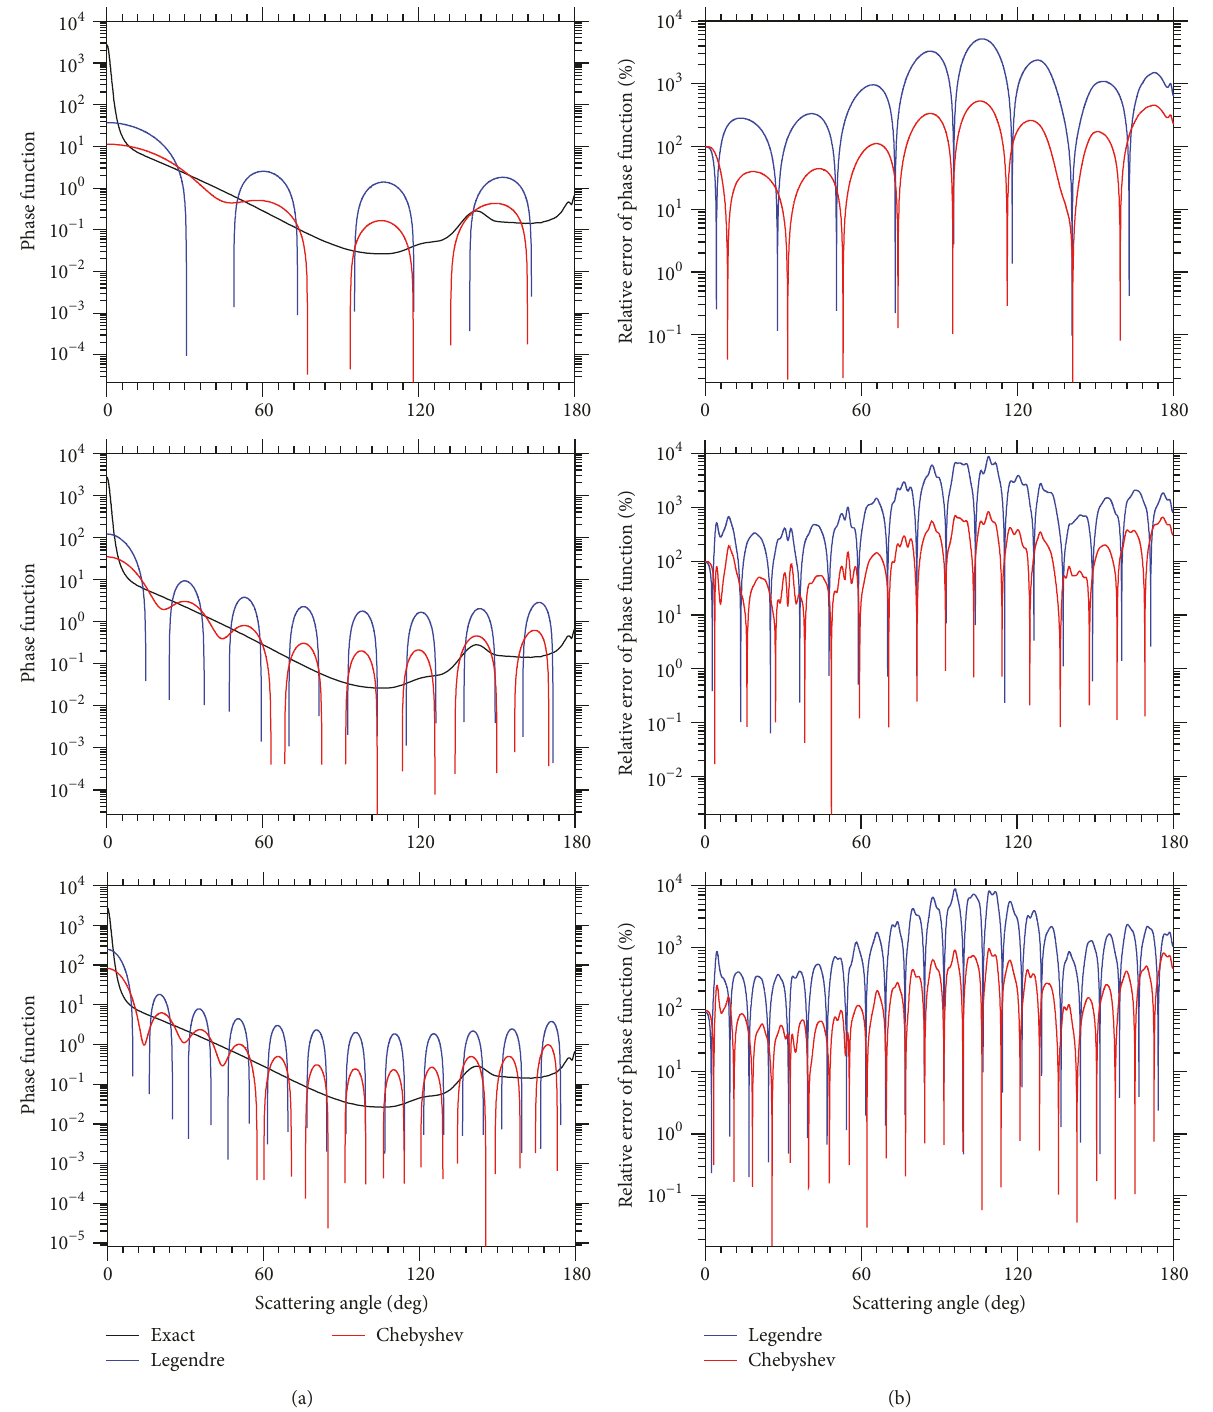
Figure 4: Phase function of black carbon internally mixed with water cloud (a) and relative error of phase function (b) in 8, 16, and 24 terms.